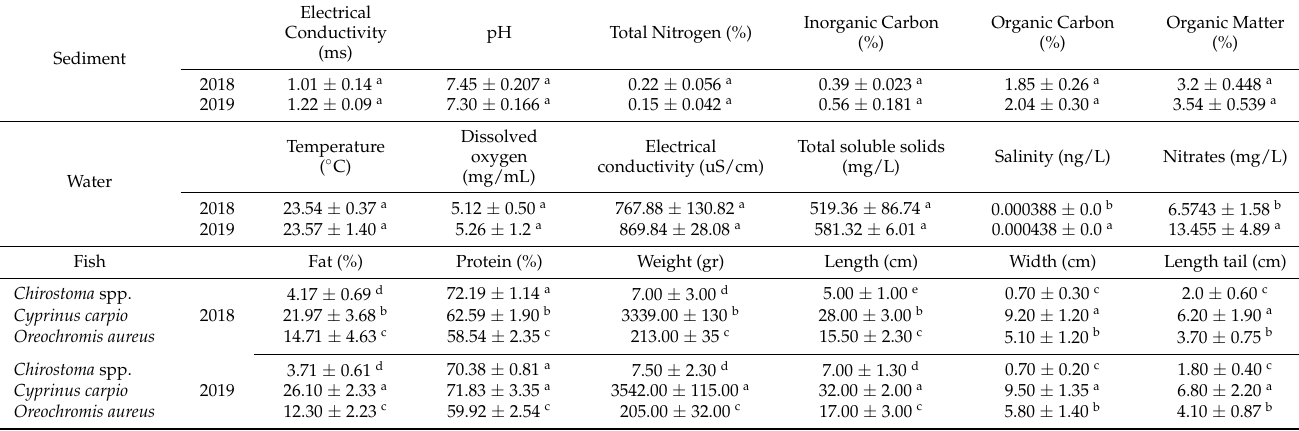
Table 1. Physicochemical parameters of sediments, water, and fish in October 2018 and May